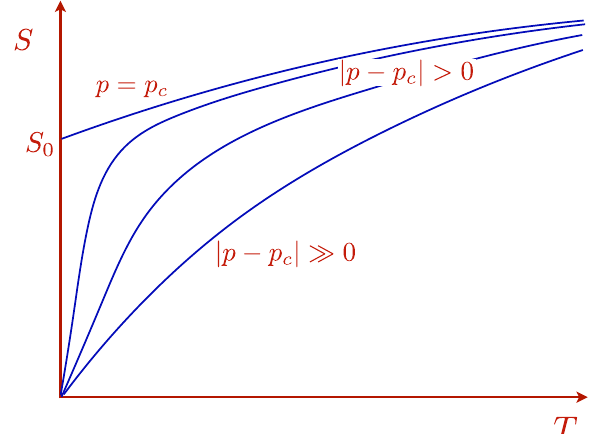
FIG. 4. Schematic plot of the temperature dependence of the entropy S of H . At p ¼ p , there is a nonvanishing extensive tJ c entropy at zero temperature S 0 . The linear-in- T coefficient of the C=T ¼ lim dS=dT diverges as we specific heat γ ¼ lim T → 0 T → 0 approach p c